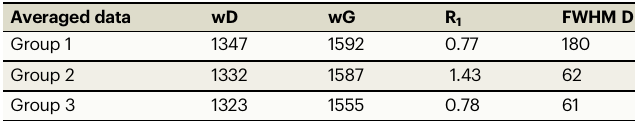
Table 1 | Raman characteristic parameters of the averaged PACM end-members Averaged